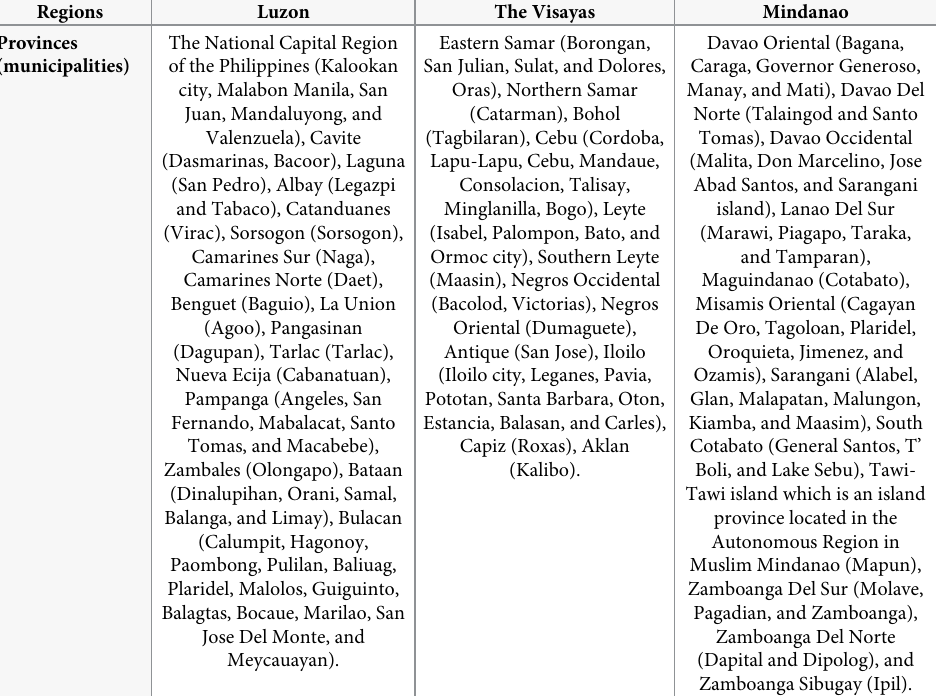
Table 11. Provinces and municipalities identified with the highest number of school-aged individuals with low levels of functional literacy.